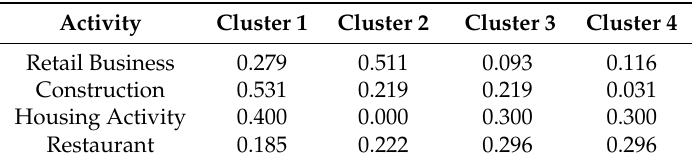
Table 4. Correlation matrix: Activity vs Cluster (PAM).